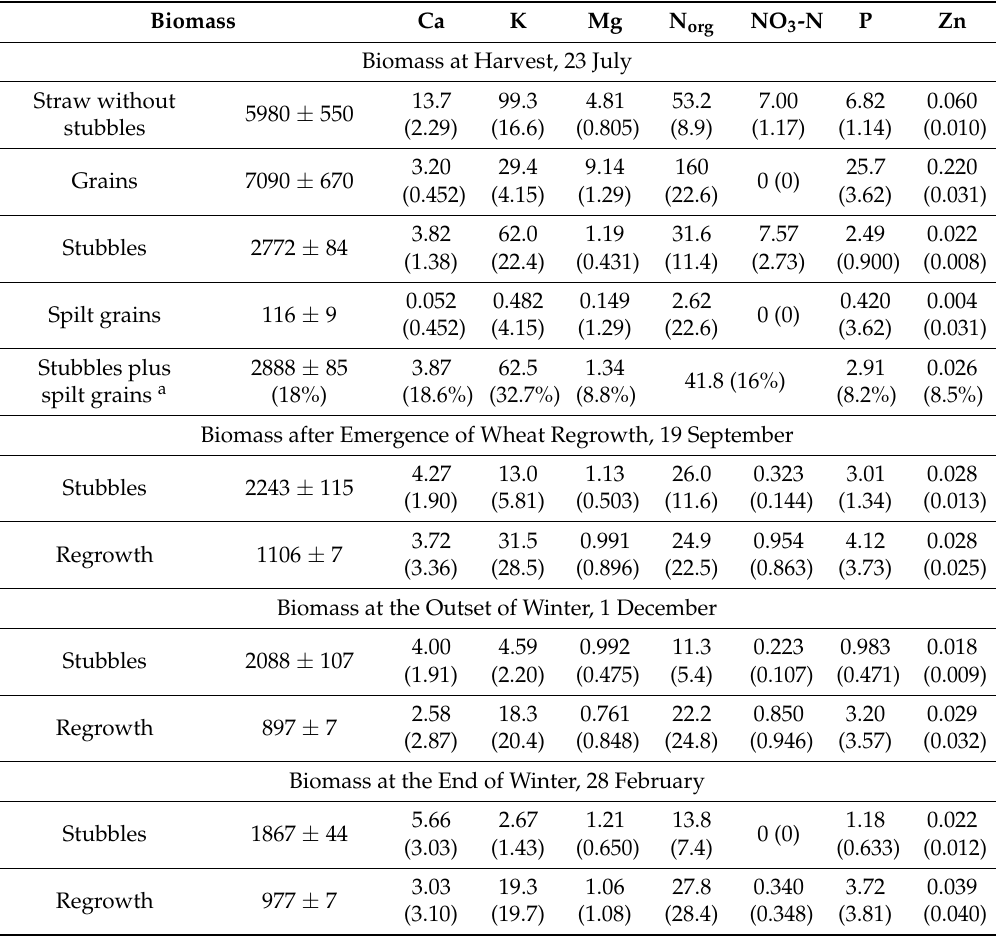
Table 3. Rotation wheat-maize: Total biomass and minerals (kg ha − 1 DW) of the harvestable wheat crop, of 16-cm stubbles (800 m − 2 ), and the regrowth of wheat cv. Kavalier emerging from spilt grains between harvest and postwinter. ( ) concentrations given in kg Mg − 1